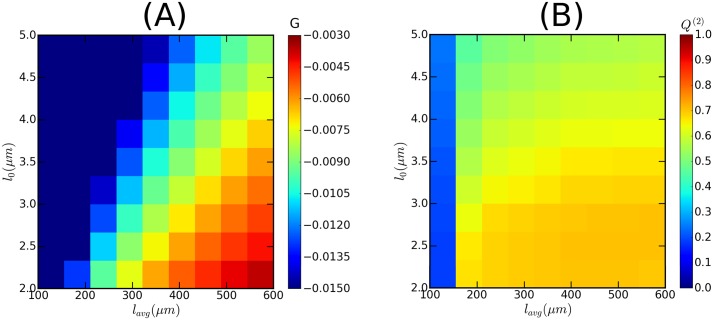
Working domain of MT simulation.Heat map showing: (A) values of MT-MT interaction control parameter G, and (B) values of the global scalar order parameter Q(2). A value of G ⪆ −0.005 assured sufficient MT-MT interaction, leading the system to achieve Q(2) ≳ 0.70 (for the time evolution, refer to S1 File, Fig S1.5). The values of G were calculated by using the MT dynamics parameter values described in [49], except the nucleation rate rn (see S1 File, Sec SI.5). To assure sufficient number of MTs, we choose rn ≈ 0.01 sec−1 μm−2. These simulations were performed using a tubulin density ρtub = 10 μm−1, defined as the ratio of the total length of MT that could be created from the available monomers to the total surface area of the shape.